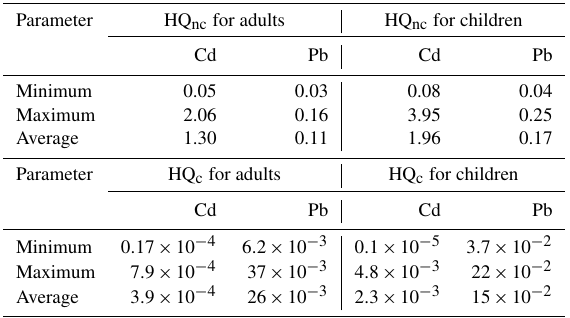
Table 4. Statistical parameters of non-carcinogenic and carcino- genic health risks for surface water samples.